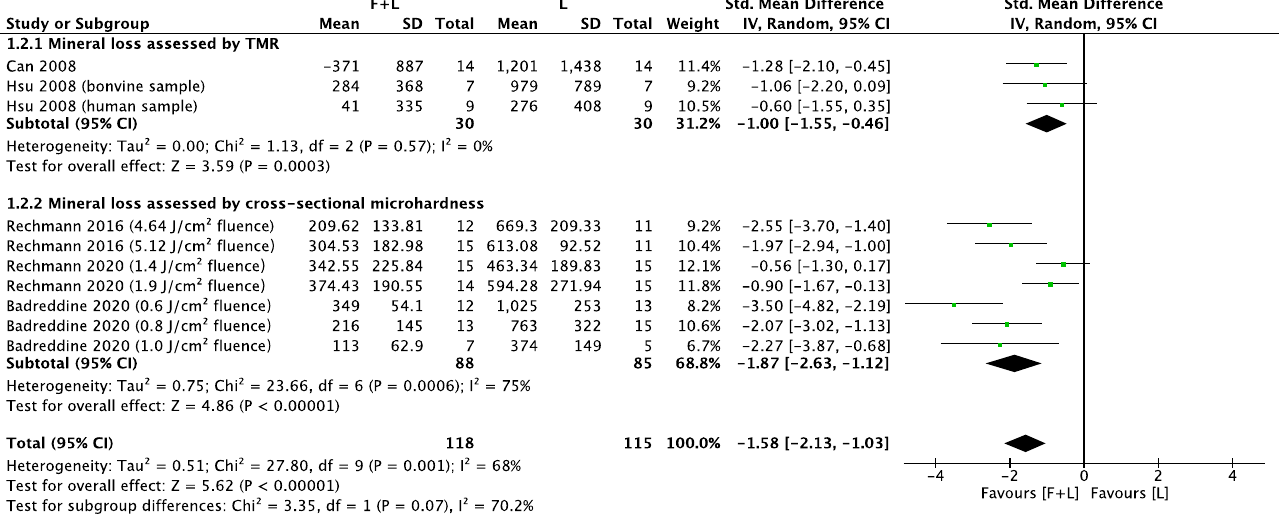
Table 3. Risk of bias of the included studies in the systematic review.